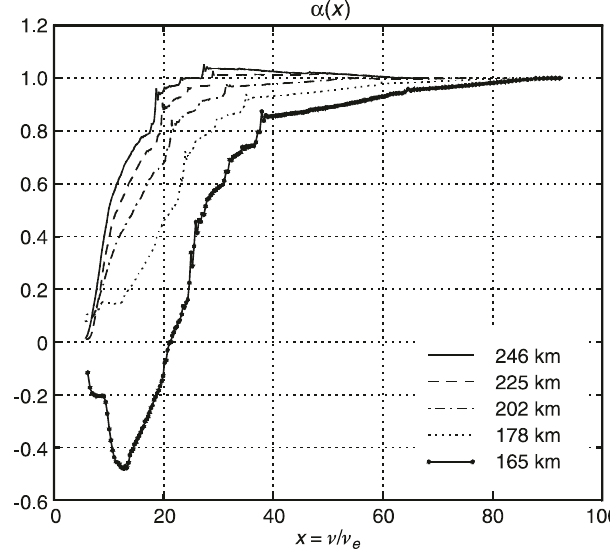
Fig. 4. The coe(cid:129)cient of location of the heat flux (cid:97) of Eq. (15) for five di(cid:128)erent altitudes for the eight-stream calculation of the transport code of the 25